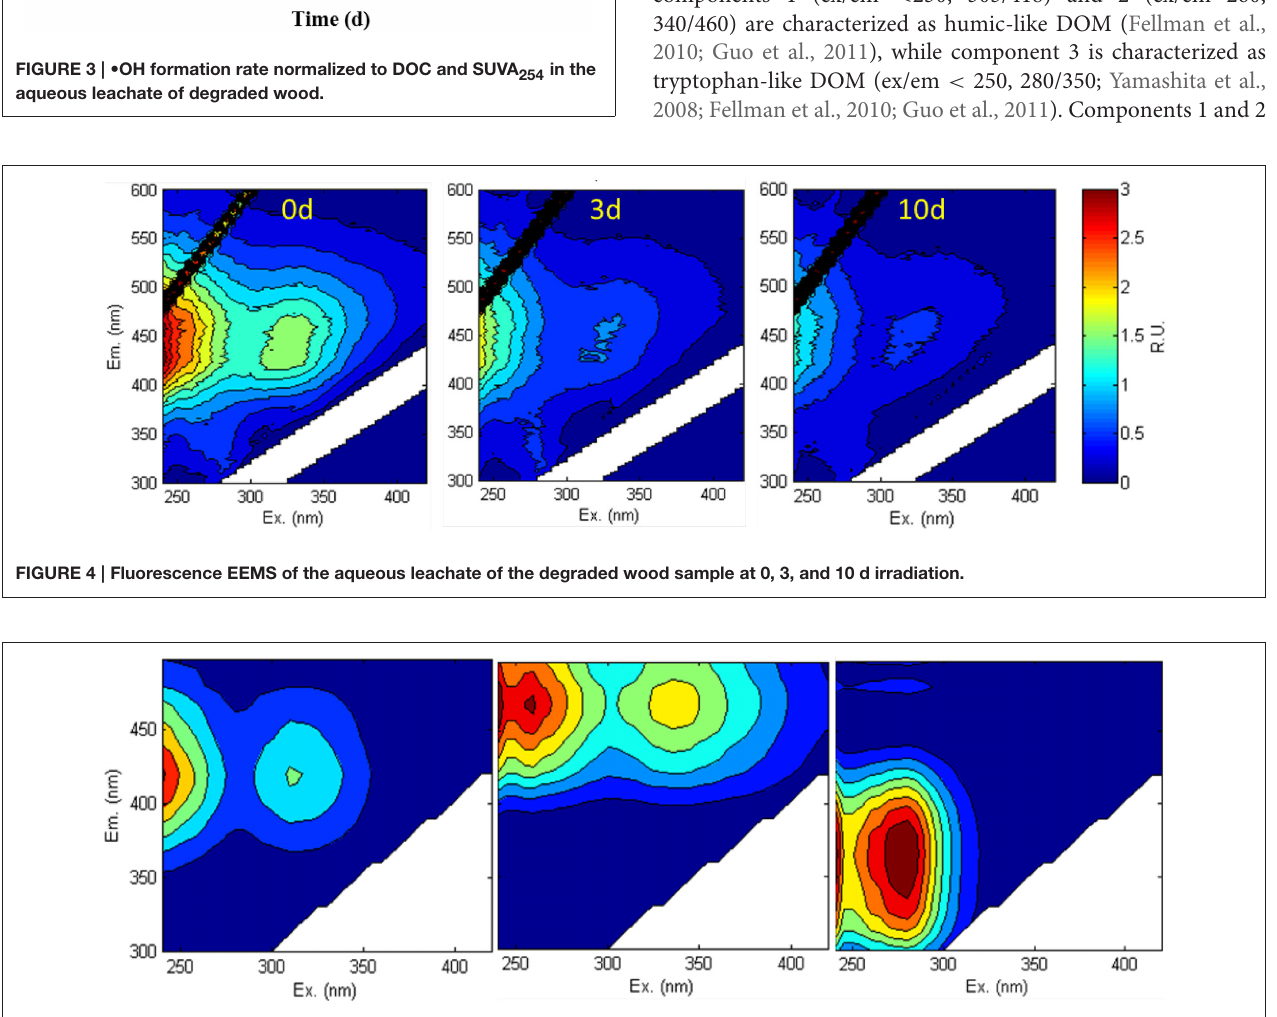
FIGURE 5 | Three components identified by PARAFAC analysis in all non-Fe-amended samples. Components 1 and 2 are humic-like DOM, and component 3 is tryptophan-like DOM.